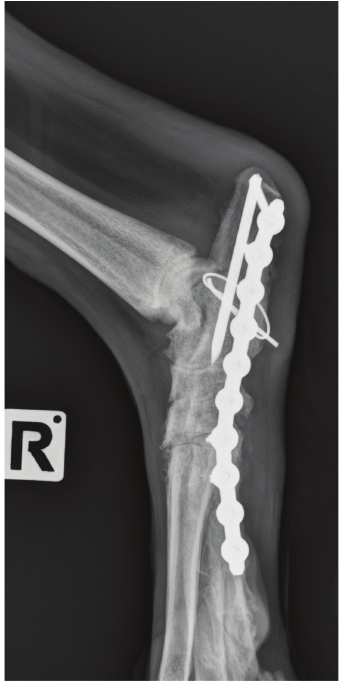
Figure 2: Postoperative radiograph showing fracture repair with 10 hole 3.5 mm SOP plate, interfragmentary and cerclage wire, and intramedullary pin.